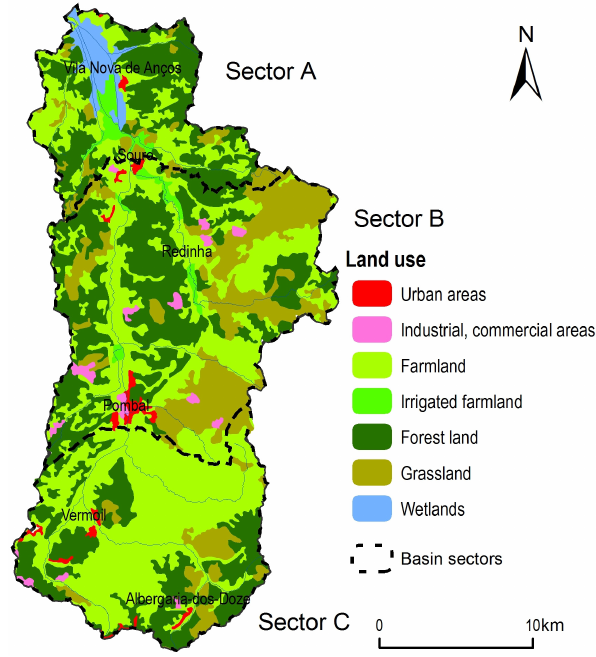
Fig. 1. Location of the Arunca River drainage basin (Central Portu- gal) and basin sectors.